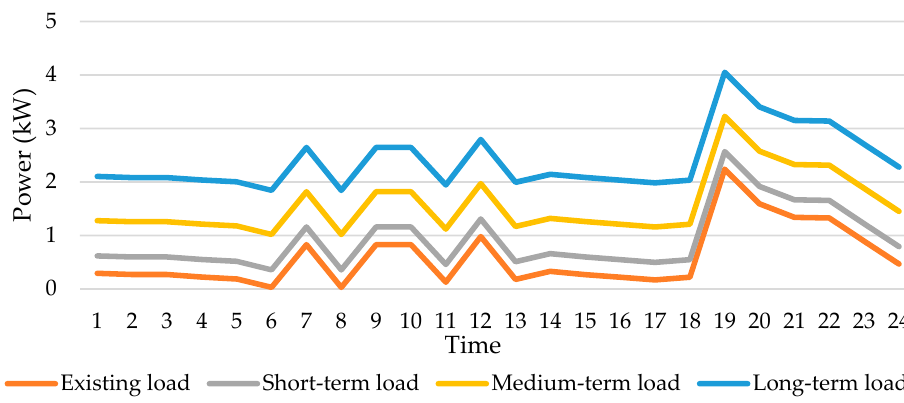
Figure 4. Projected daily load profile for the 11 Households with 24-h electricity access.